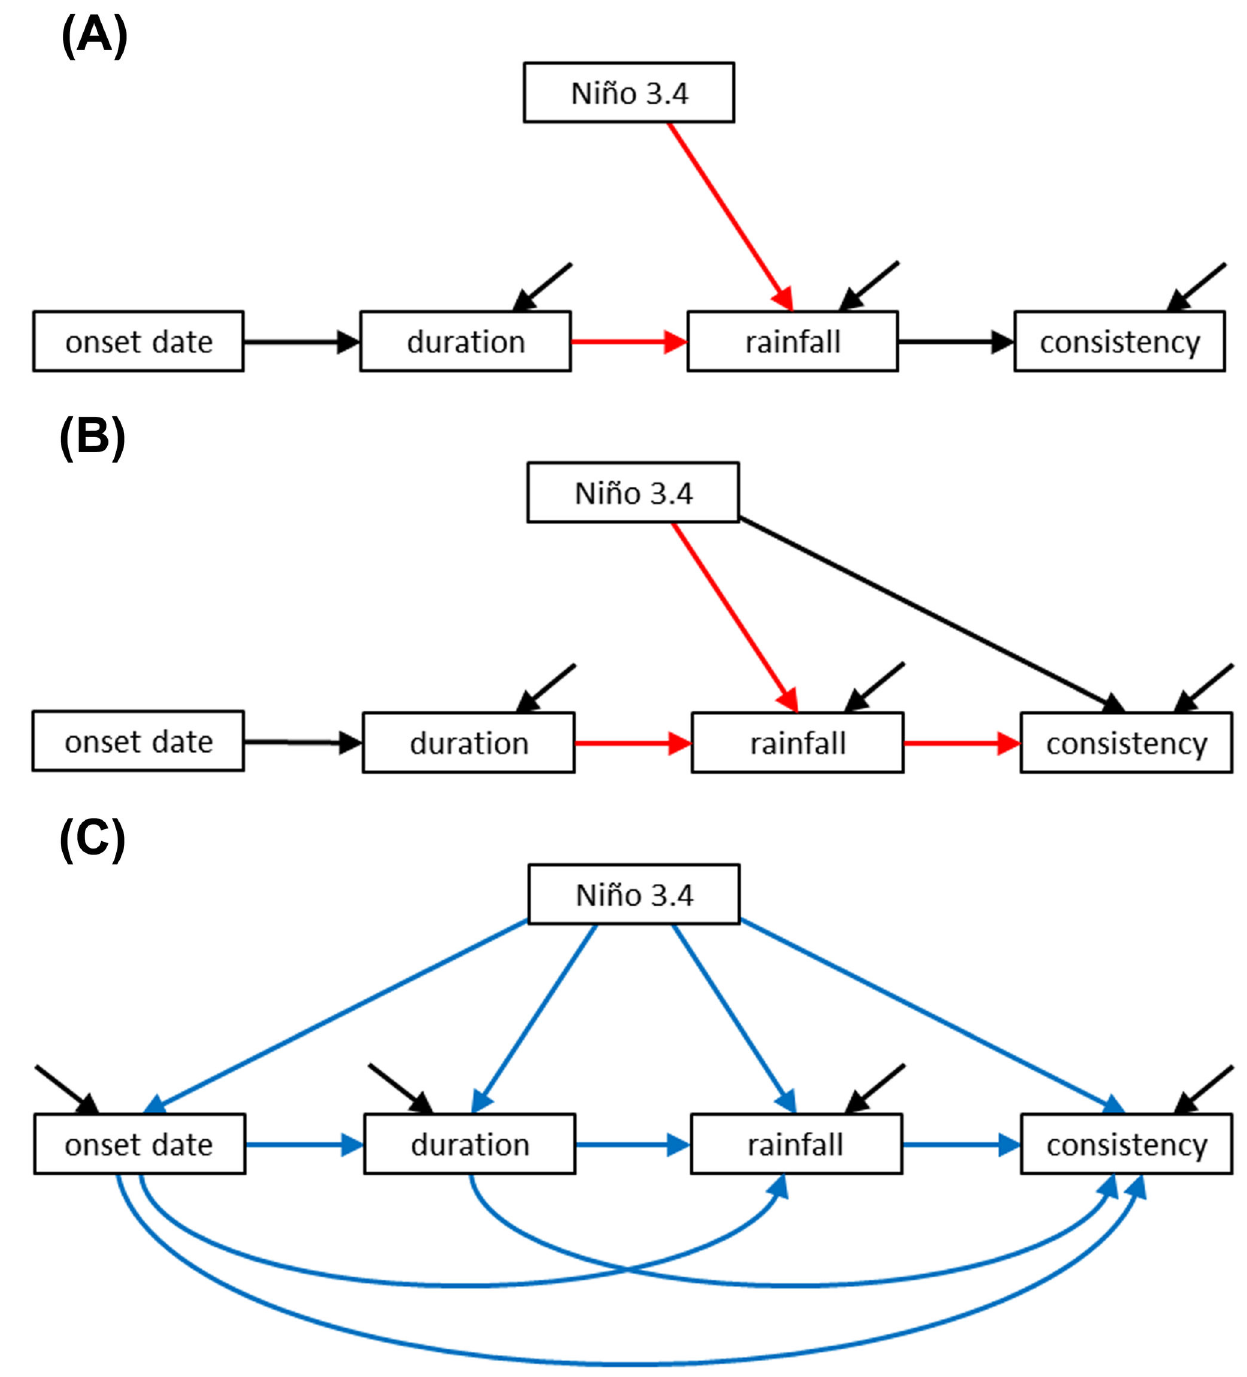
Figure 1. Conceptual causal diagrams describing relationships among descriptors of ENSO and the seasons. We designed these models for (A) the dry season and (B) the wet season based on relationships that have support from previous studies (see text). Arrows are coded to represent predicted effects (black = negative effect, red = positive effect). Using these starting models as a basic framework, we designed a third model (C) which specified all possible relationships among the seasonal descriptors (blue arrows). This latter model was saturated and was used to produce exploratory models using Amos’s model specification procedure. In all panels, diagonal black arrows represent error terms.